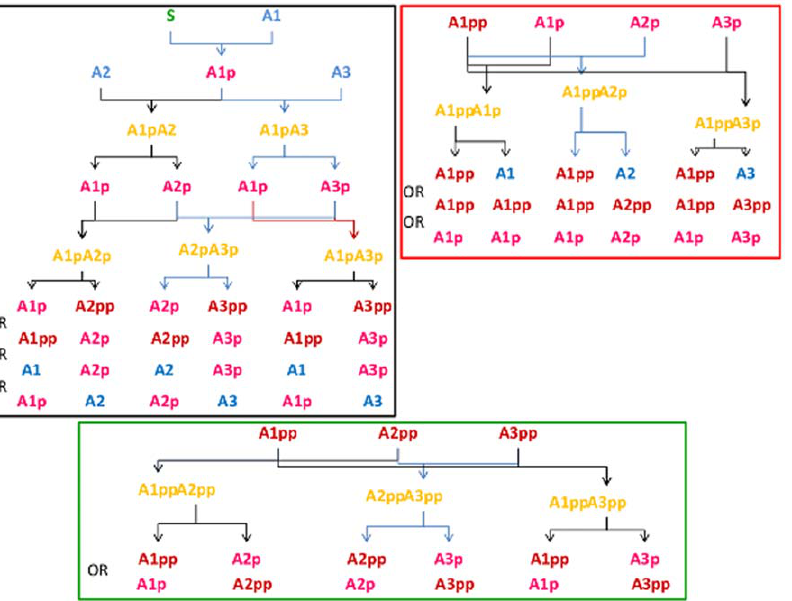
Figure 9. List of possible reactions in the minimal model with three proteins. S represents the input signal, A 1 , A 2 , and A 3 denote inactive signaling proteins, their partially active (single phophorylated) forms are A 1 p , A 2 p , and A 3 p , respectively. The fully active forms are A 1 pp , A 2 pp , and A 3 pp .